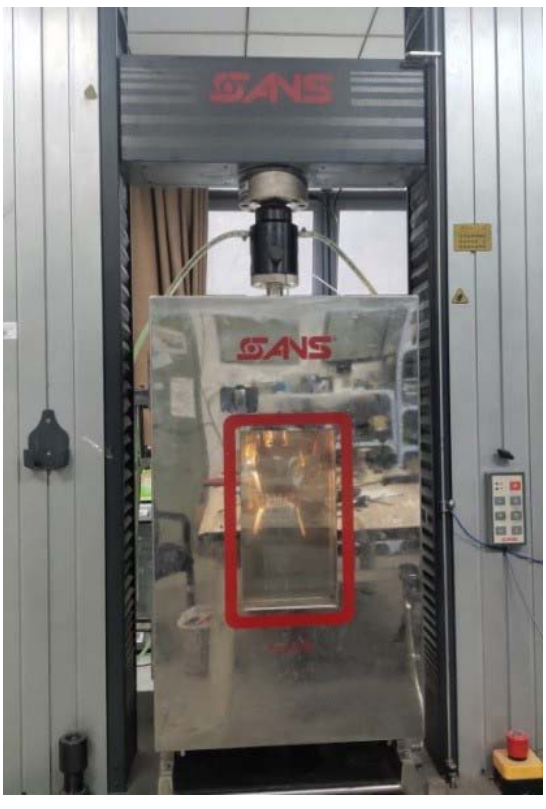
Figure 2. The MTS tensile testing system with a controllable environmental chamber.